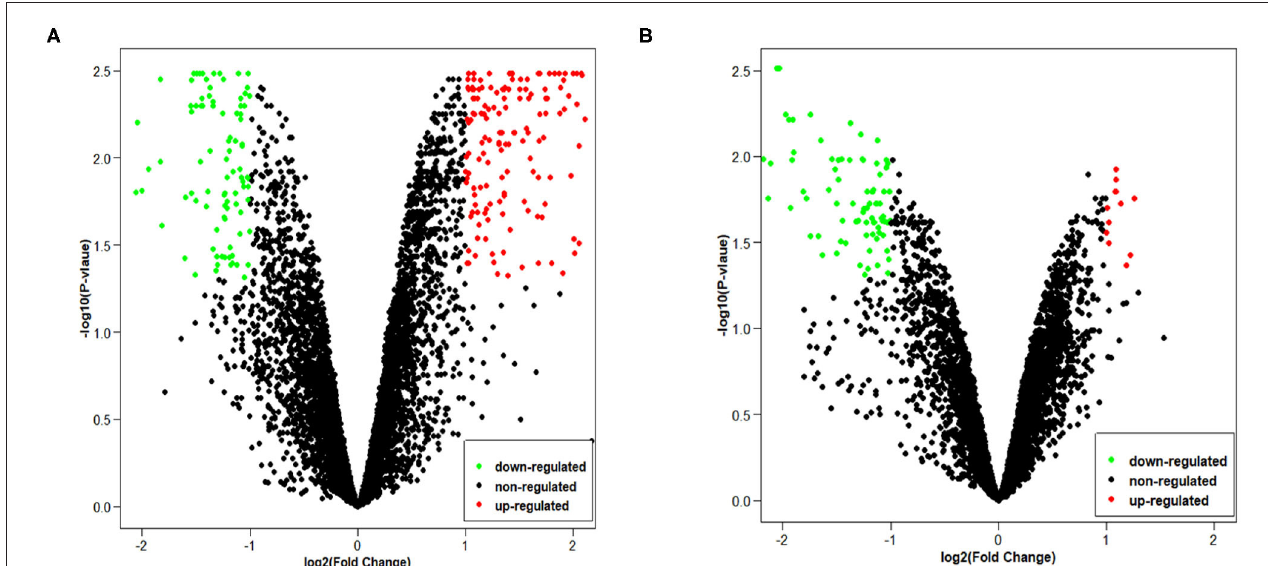
FIGURE 2 | The volcano plots of two chips: (A) GSE101684, (B) GSE112214.